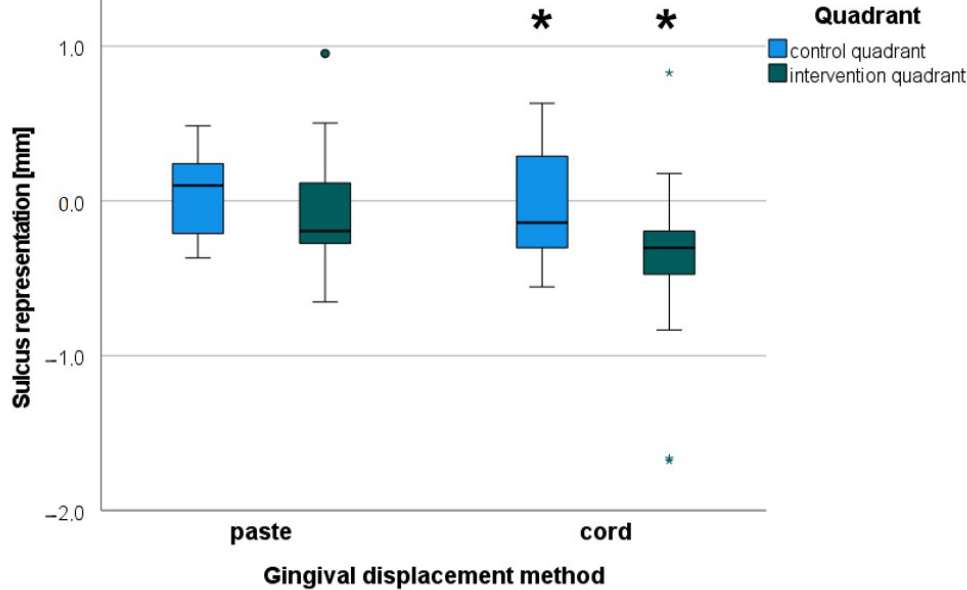
Figure 6. Sulcus representation for control quadrant (before inducing gingivitis at Visit 5) versus intervention quadrant (first intervention); negative value: displacement of the sulcus apically com- pared to reference impression; * (large asterisks): significant ( p < 0.05); the circle represents an outlier value (more than 1.5 times the box width away); the little asterisks represent extreme values (more than 3 times the box width away).